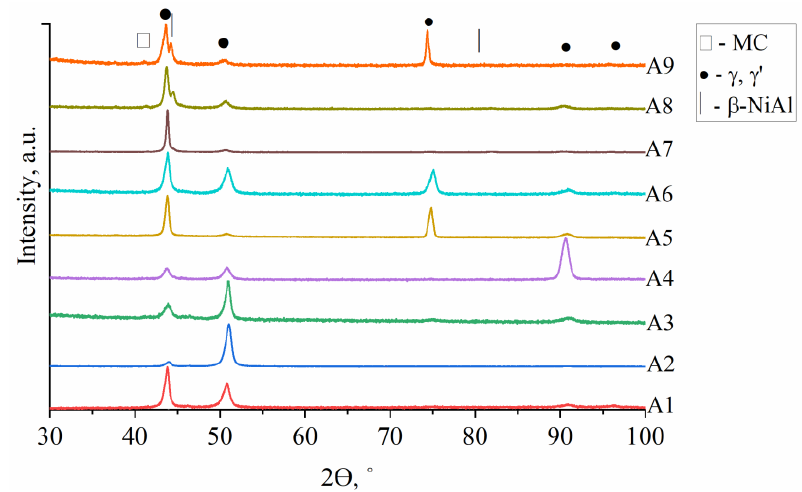
Figure 3. XRD spectra of the as-cast A1 – A9 superalloys.